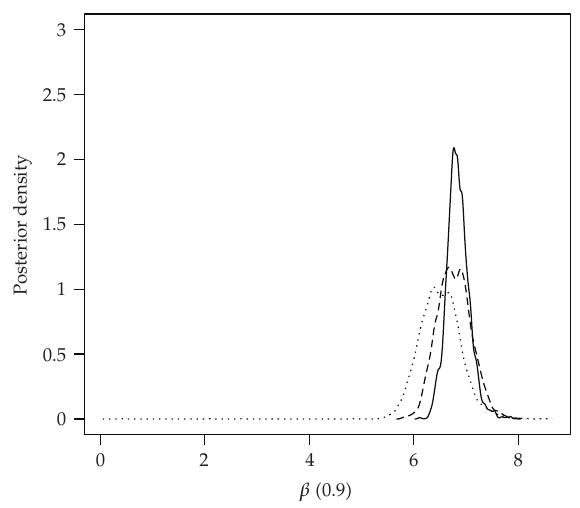
Figure 1: Plots of posterior densities for β 0 . 90 , where the dotted curve is for improper uniform prior, the dashed and solid curves are for power priors with parameters (cid:2) μ a (cid:2) 0 . 99 , 0 . 010 (cid:5) , respectively.